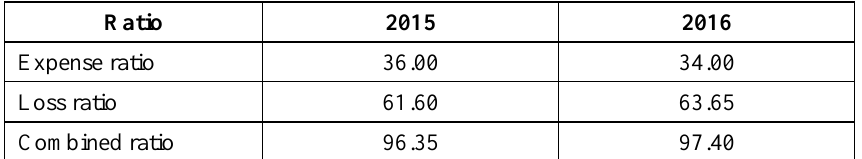
Table 4. Key median factors for non-life Baltic insurance market, percentages